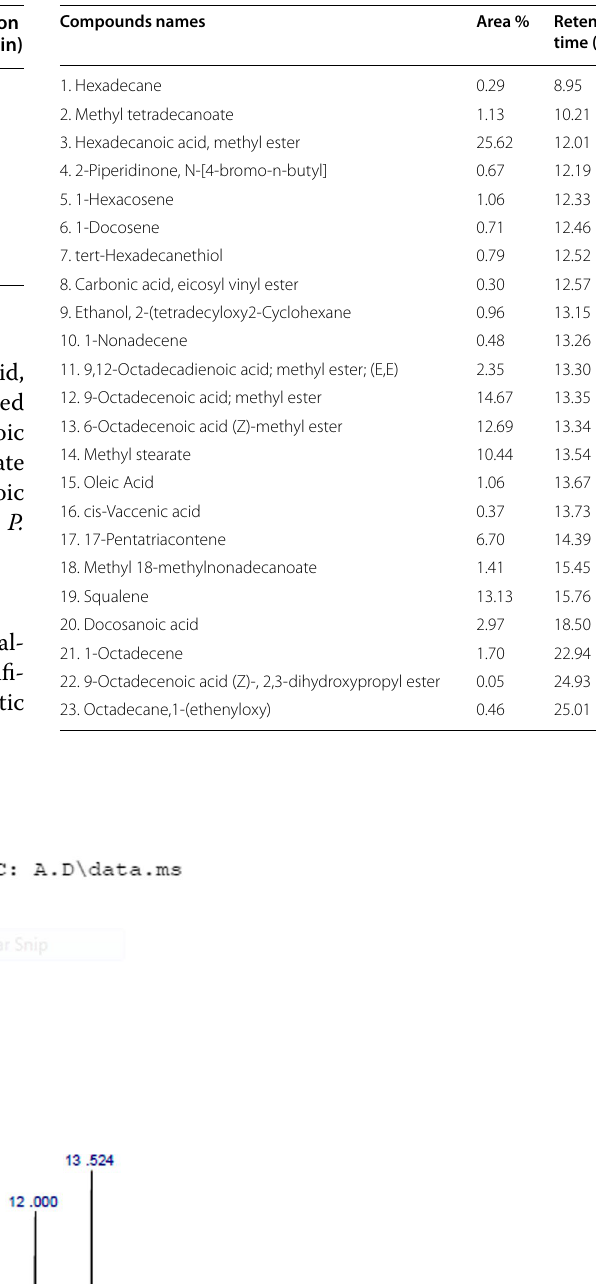
Table 11 Phytochemical Constituents of Methanol Extract of Costus afer leaf identified by GC–MS